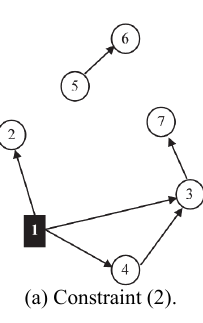
Fig. 2. Impact of the spanning tree constraints in the LOVRP